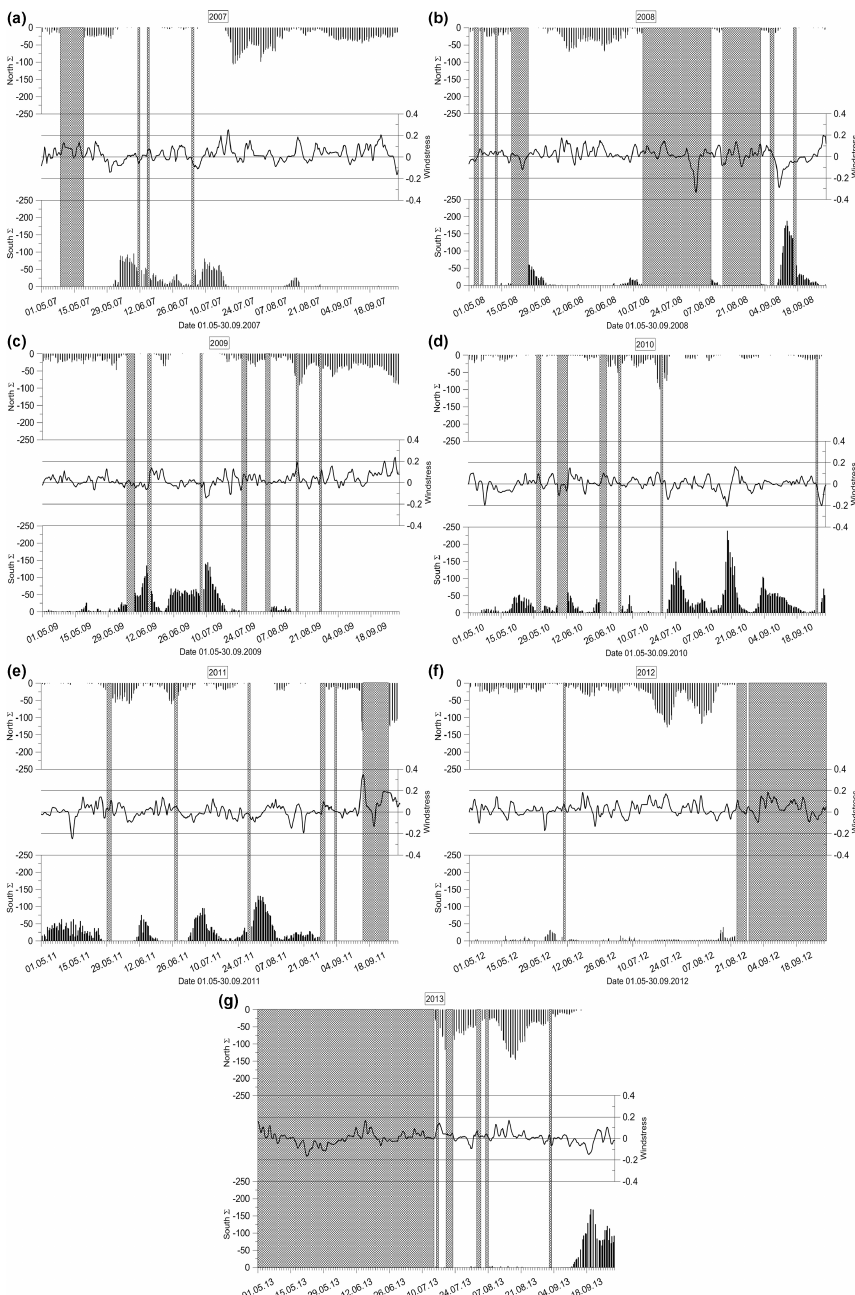
Figure 5. Temporal changes in upwelling index off the northern coast (at the top of each subplot; ◦ C) and off the southern coast (at the bottom of each subplot; ◦ C) and along-gulf wind stress (black curve in the middle; Nm − 2 ) in May–September 2007 (a) , 2008 (b) , 2009 (c) , 2010 (d) , 2011 (e) , 2012 (f) and 2013 (g)